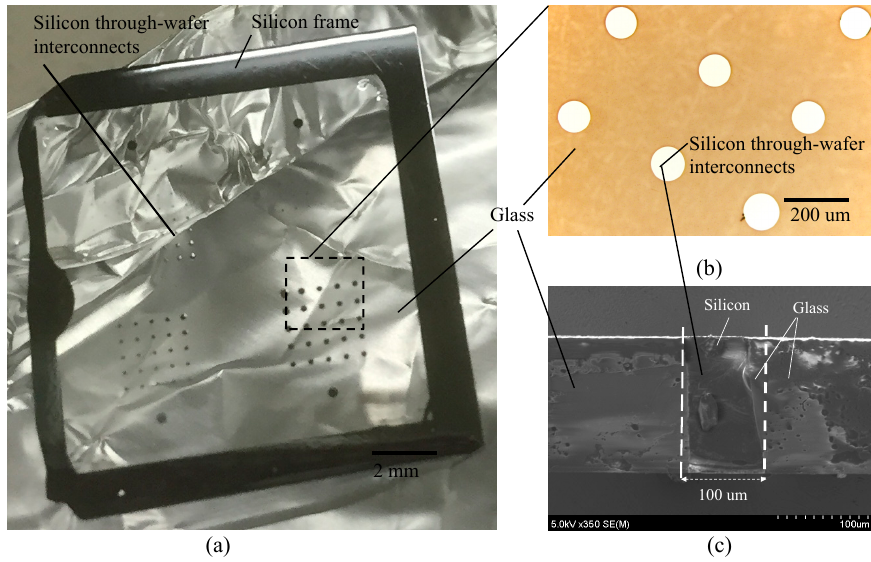
Figure 4. ( a ) View of 2 (cid:2) 2 cm 2 silicon-in-glass wafer; ( b ) Top view; ( c ) Cross-sectional view.